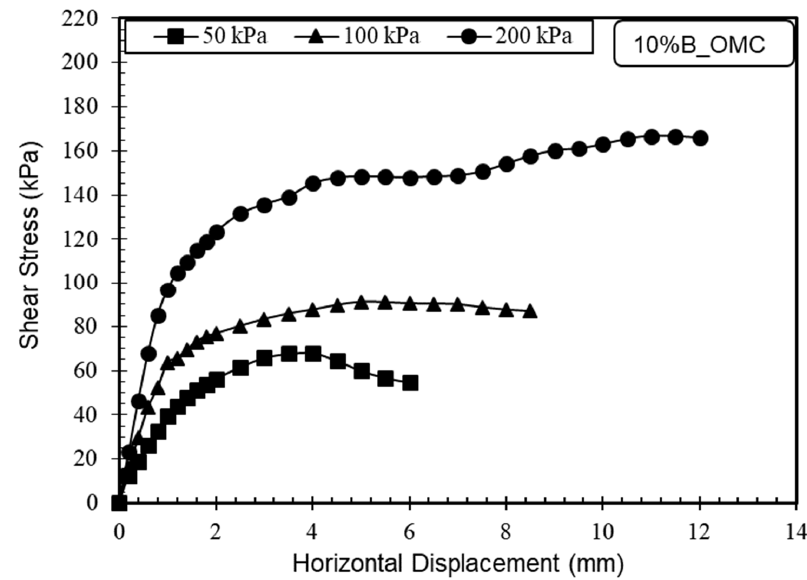
Figure 13. Horizontal displacement vs. shear stress for mixture with 10% bentonite under OMC condition.